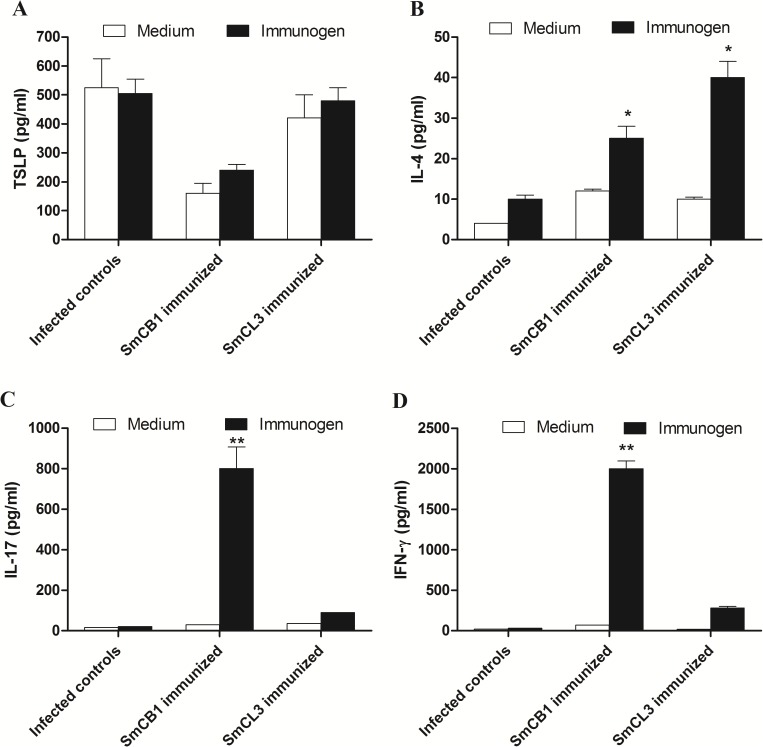
Cytokine response of SmCB1- and SmCL3- immunized mice to the immunogen.Each column represents mean +/- SD cytokine levels in epidermal (A) and lymph node (B-D) cell cultures (three mice per group), 2 (epidermal cells, A) and 4 (LNC, B-D) days after infection. Asterisks indicate significance (* P < 0.05, ** P < 0.005) of differences between levels of cytokines released in cultures stimulated with 0 (medium) or 20 μg/ml immunogen.